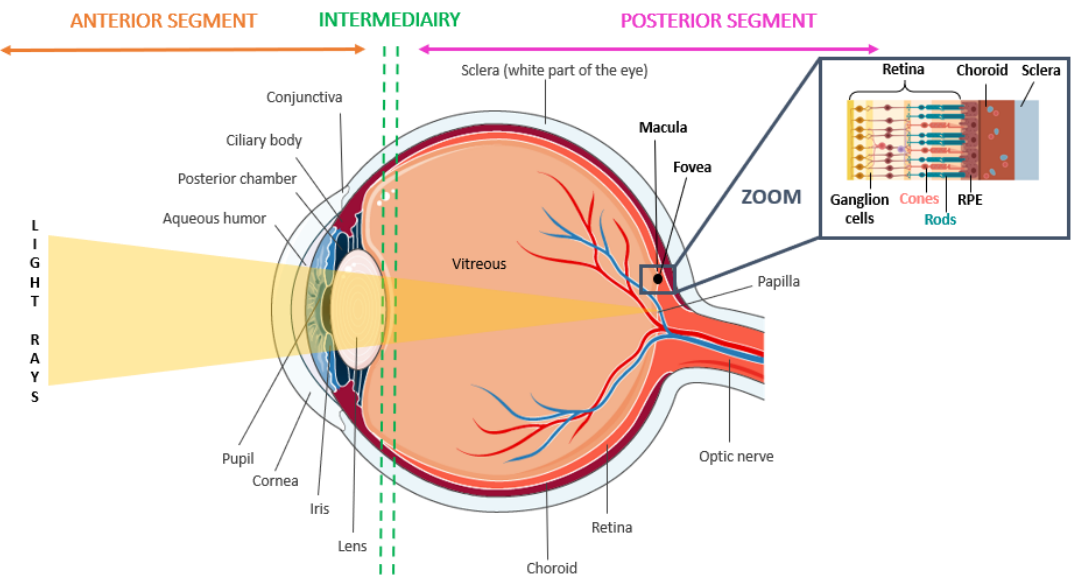
Figure 1. Anatomy of the eye divided into different segments (anterior, intermediate, and posterior) including the macula corresponding to the AMD disease area.